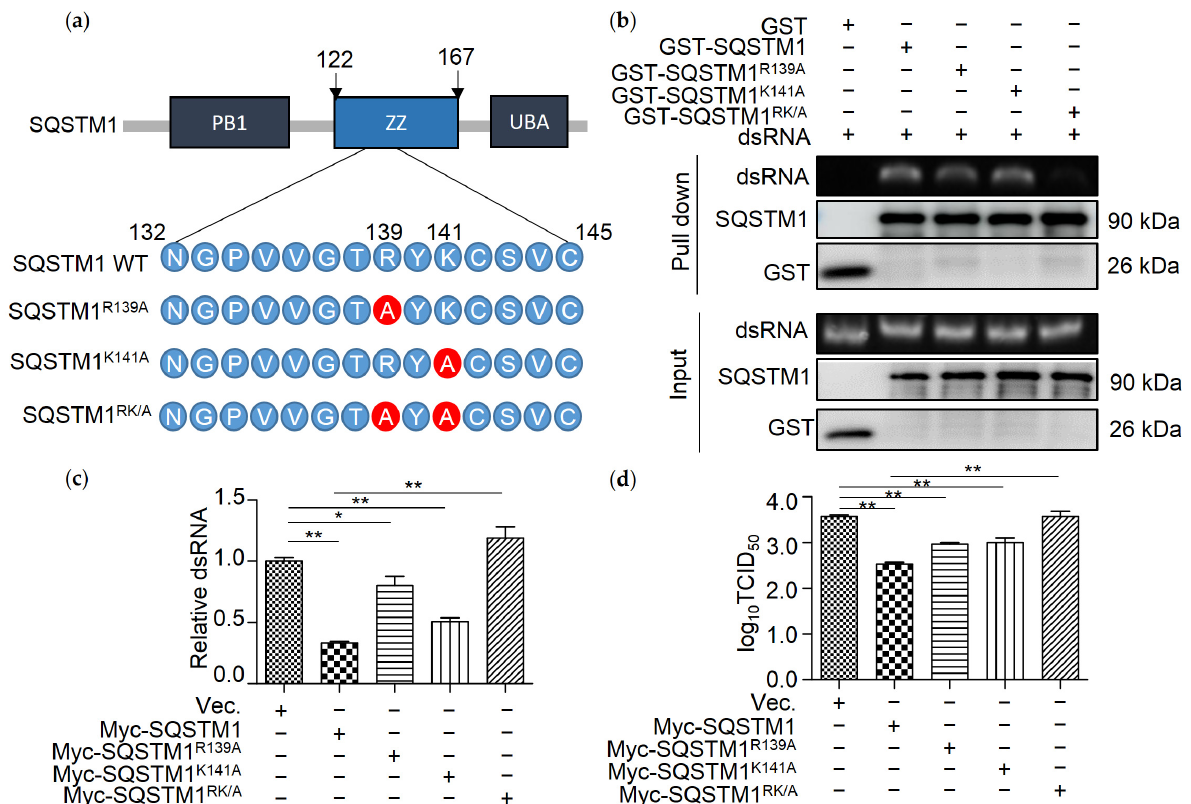
Figure 5. R139 and K141 are necessary for SQSTM1-mediated degradation of dsRNA. ( a ) Diagram of SQSTM1 and its variants SQSTM1 R139A , SQSTM1 K141A , SQSTM1 RK/A . ( b ) R139 and K141 are necessary for dsRNA binding. Prokaryotically expressed protein GST-SQSTM1 and its variants GST-SQSTM1 R139A , GST-SQSTM1 K141A , and GST-SQSTM1 RK/A were separately incubated with IBDV dsRNA for 4 h, and RNA binding protein immunoprecipitation assay was performed using anti-GST resin. RK/A variant of GST-SQSTM1 showed reduced IBDV dsRNA binding compared to wild type. ( c ) R139 and K141 are critical for degrading dsRNA of SQSTM1. IBDV dsRNA and empty vector (Vct.) or vector expressing Myc-SQSTM1 and its variants (Myc-SQSTM1 R139A , Myc-SQSTM1 K141A , Myc-SQSTM1 RK/A ) were cotransfected into 293T cells. Total RNA was extracted, and qRT-PCR was performed to determine the IBDV dsRNA and β -Actin mRNA from 293T cells. ( d ) R139 and K141 are important for the replication of IBDV. Myc-SQSTM1 and its variants (Myc-SQSTM1 R139A , Myc-SQSTM1 K141A , Myc-SQSTM1 RK/A ) were transfected into 293T cells, respectively, for 18 h, then infected with IBDV at MOI = 0.1 for 18 h. The replication of IBDV was detected by performing the TCID 50 assay. Data were represented as mean ± SD of three independent experiments. NS, not significant ( p > 0.05); * p < 0.05, ** p <